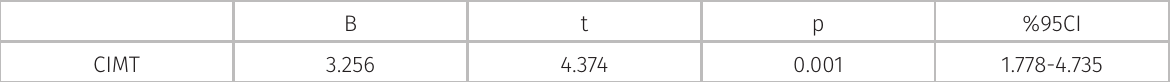
Table V. Independent predictors for Epicardial fat thickness (EFT) by multivariate linear regression analysis. B t p %95CI CIMT 3.256 4.374 0.001 1.778-4.735 CIMT, carotid intima-media thickness. B, Regression coefficient; t, Degree of freedom; CI, confidence interval; p<0.05 was considered statistically significant. (R 2 =0.171 F=19.130). (p>0.05 was excluded).